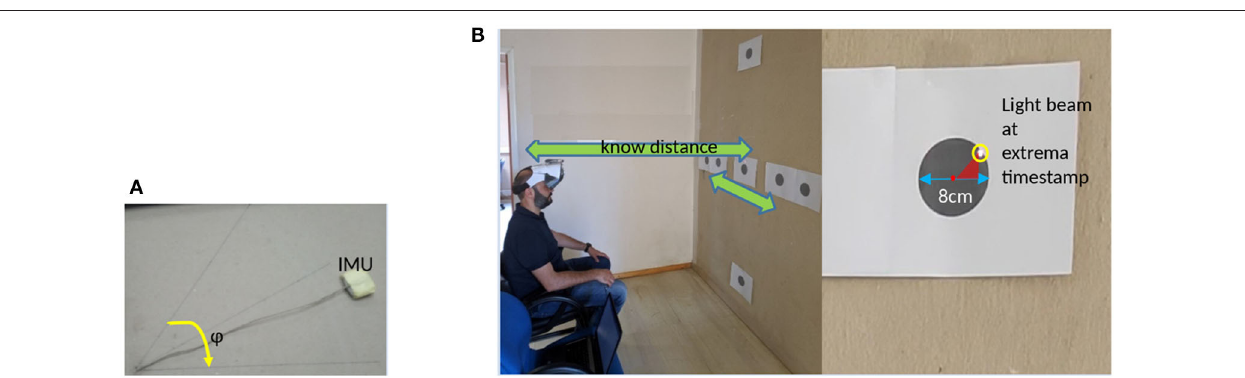
FIGURE 4 | Experimental setups for validating IMU data. (A) 2D validation setup and (B) 3D validation